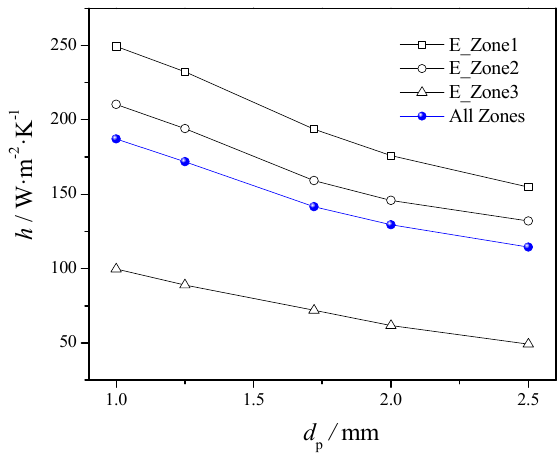
Figure 11. Variations of heat transfer coefficients of particle flow around an elliptical tube with different diameters ( v out = 2 mm/s).